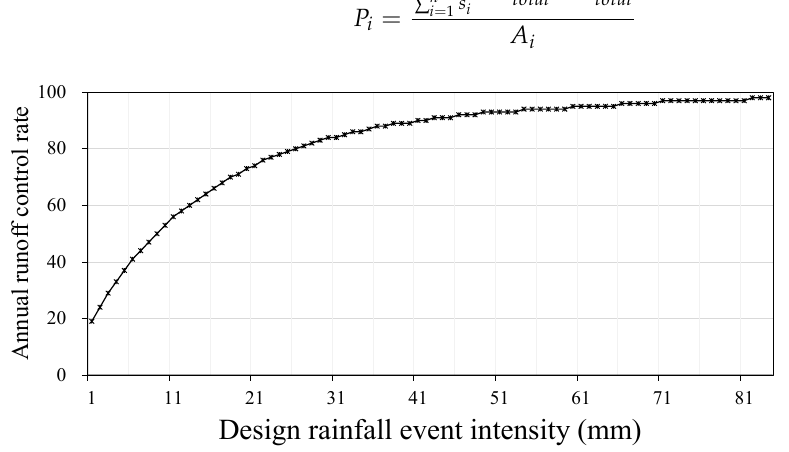
Figure 3. Relationship between ARVCR and design rainfall intensity.